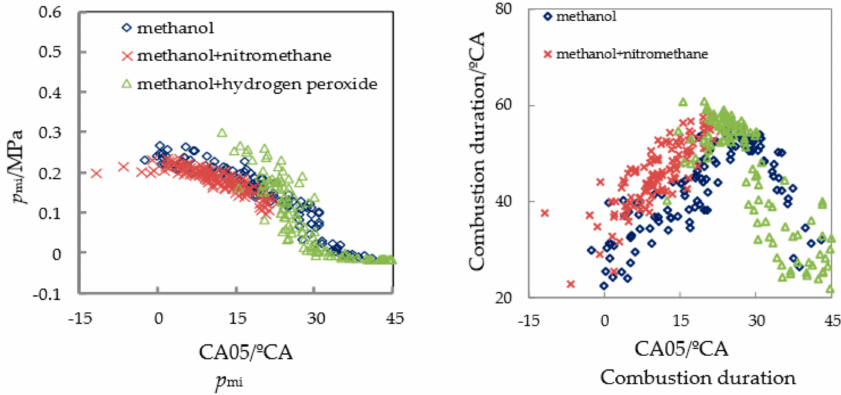
Figure 12. Pmi and combustion duration correlated with CA05 with di ff erent additives.